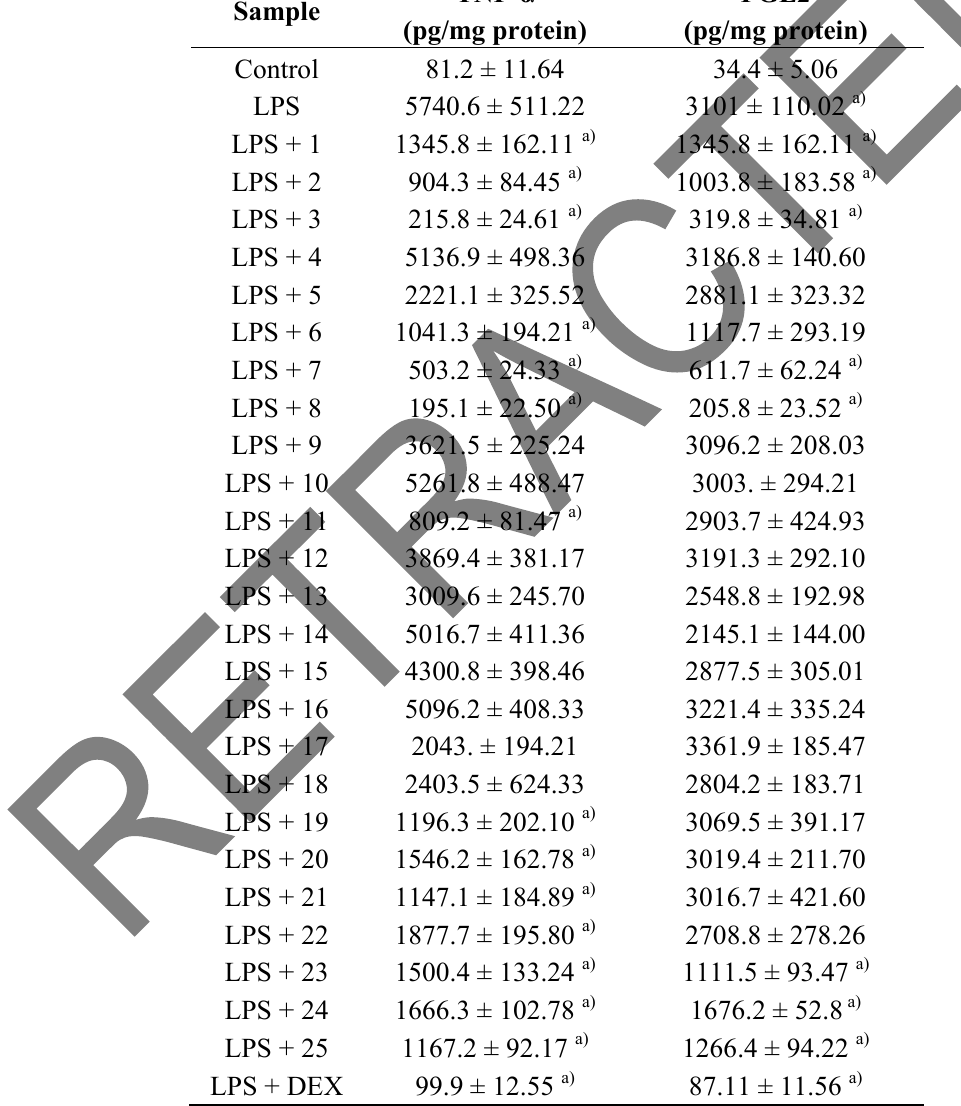
Table 2. Effect of different compounds on the levels of TNF- α and PGE-2 in LPS-stimulated